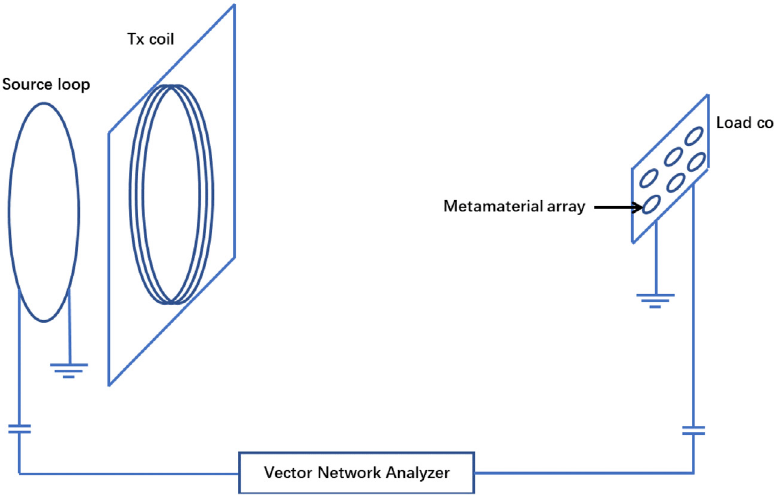
Fig. 7. Schematic diagram of three coil WPT systems.